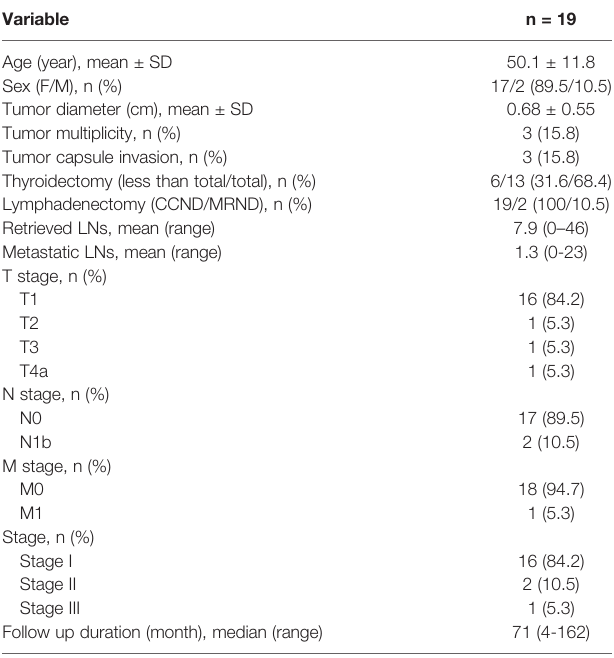
SD, Standard deviation; CCND, central compartment neck node dissection; MRND, modi fi ed radical neck node dissection; LN, lymph